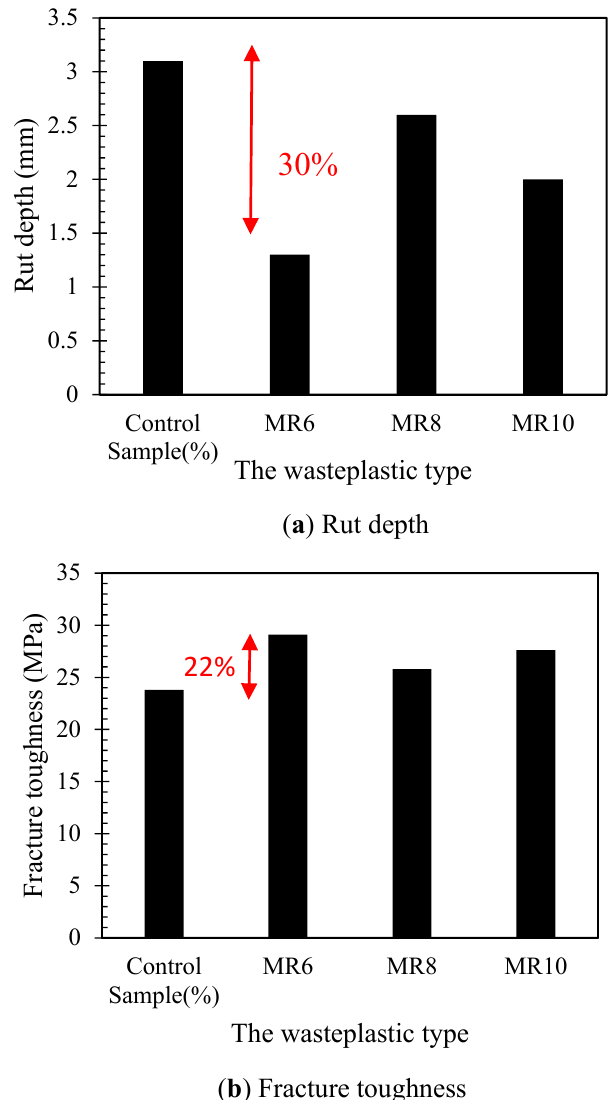
Figure 4. Effect of MR6, MR8 and MR10 on the performance of the mixture, plotted based on data reported by White and Reid [29].